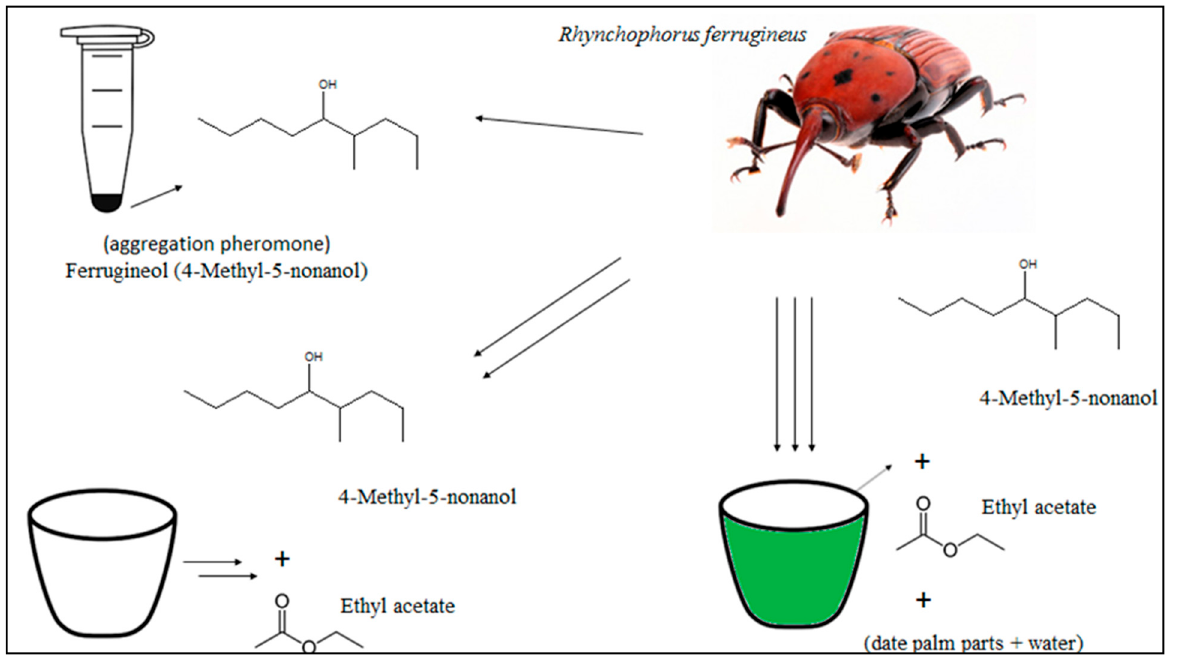
Figure 2. Pictorial scheme of the source used for Rhynchophorus ferrugineus